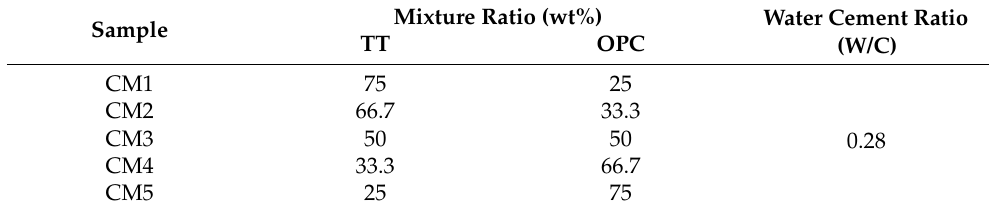
Table 2. Mixture formulations (wt%) for OPC and